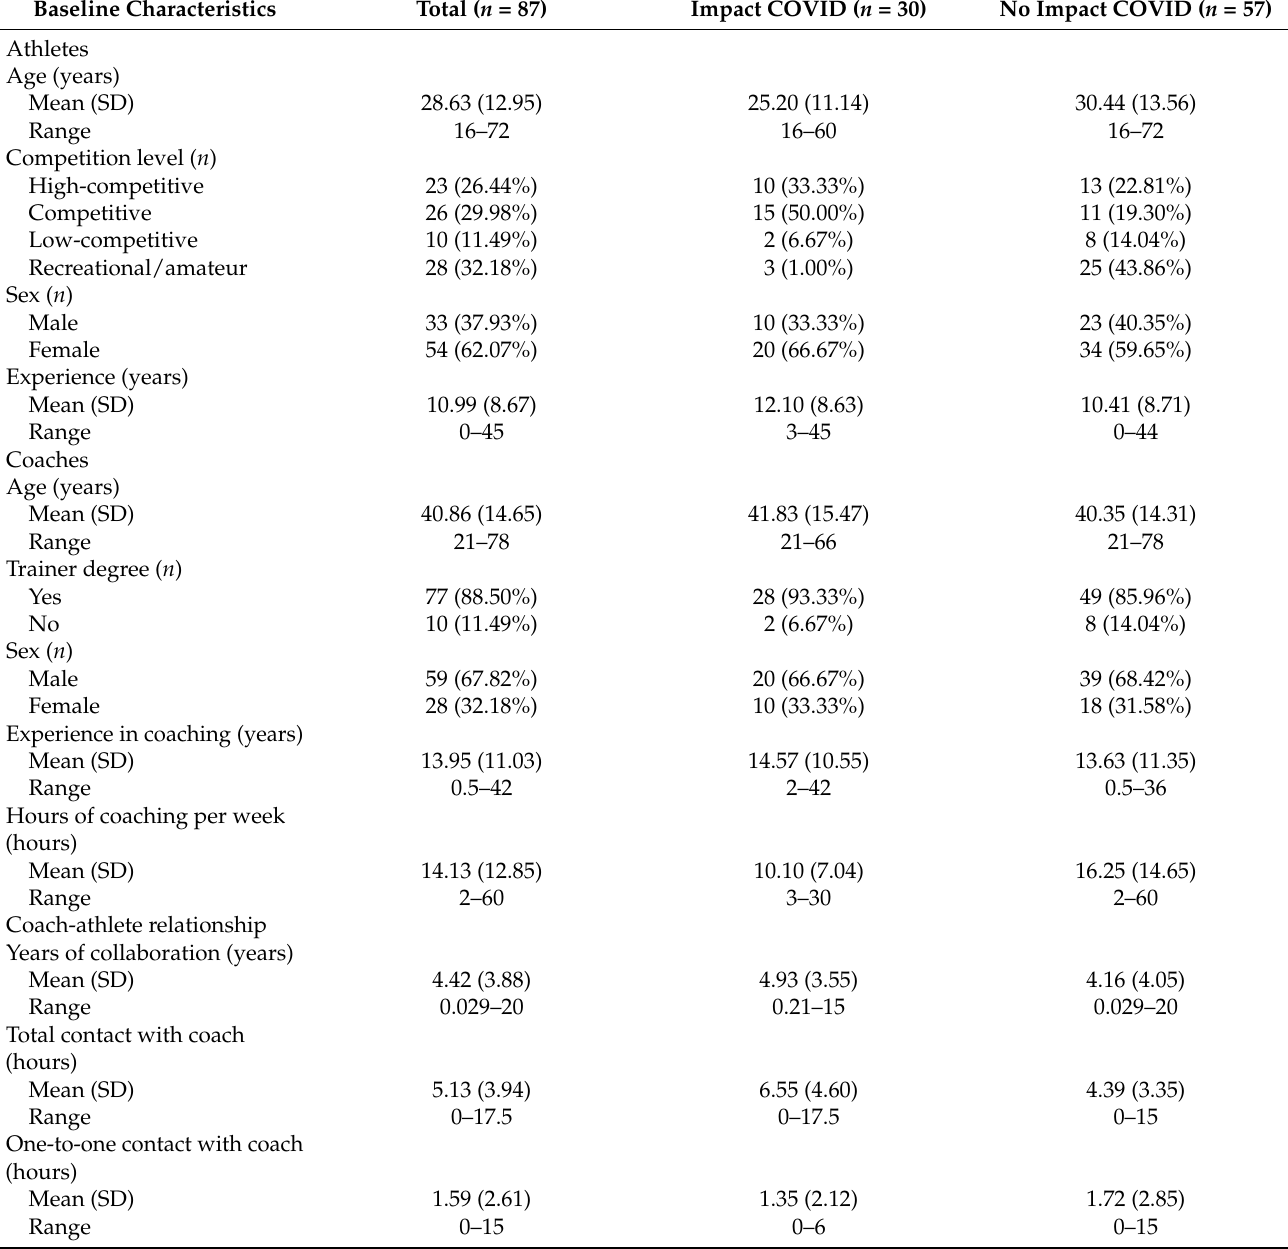
Table 1. Demographic information for the total sample, the dyads that reported being affected by the pandemic and the dyads that reported not to be affected by the